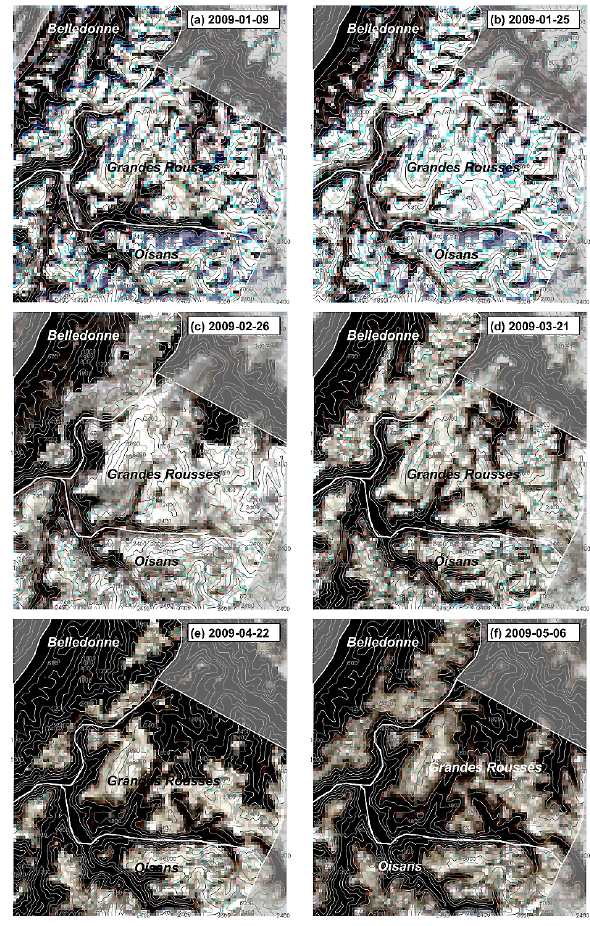
Fig. 4. Colour composite of MODIS images of study area (Fig. 1) using bands 1 (red), 3 (blue), 4